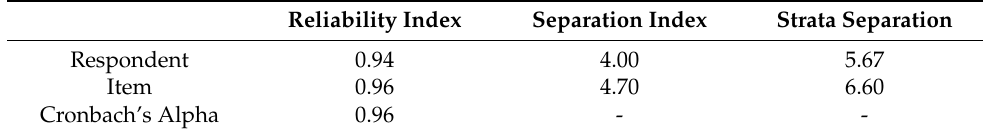
Table 5. Reliability index and separation index.